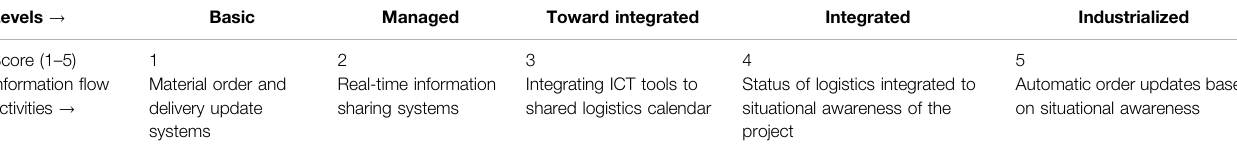
TABLE 9 | Information fl ow